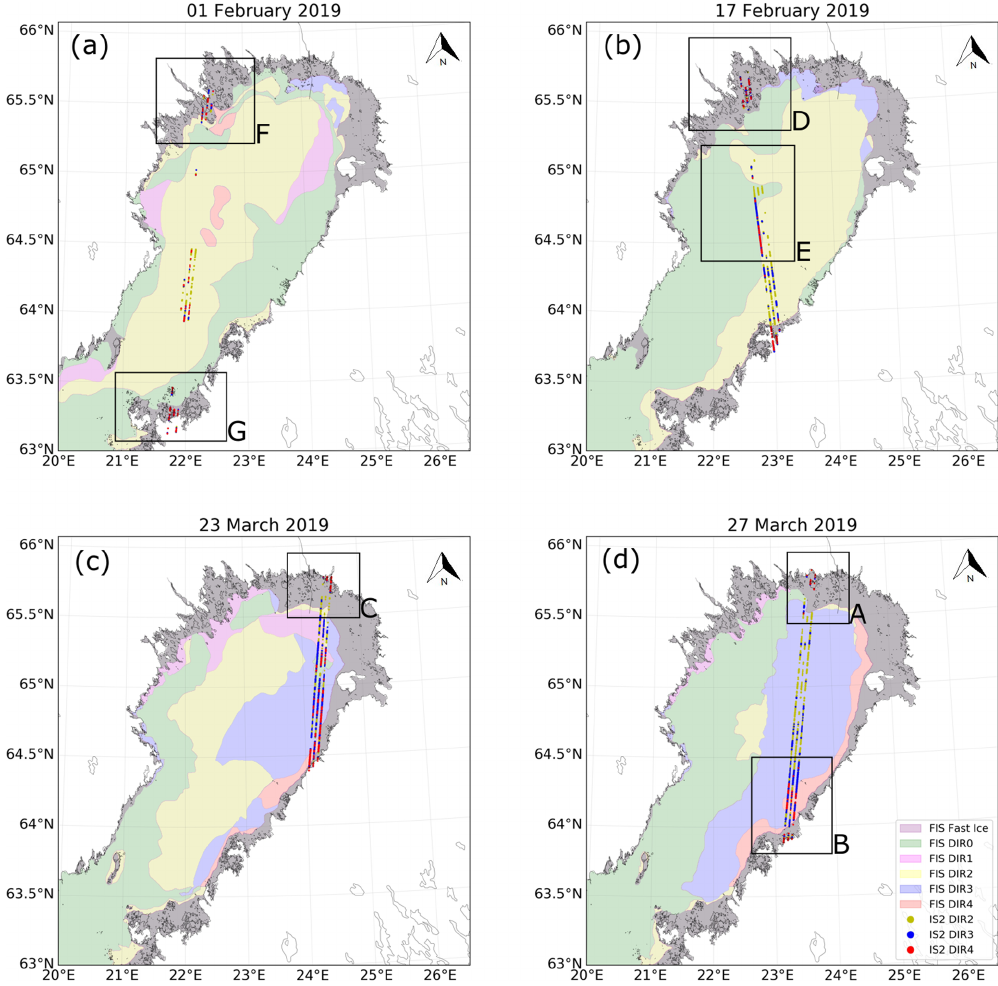
Figure 4. Categorised DIR data over four available dates (strong beams): (a) 1 February, (b) 17 February, (c) 23 March, and (d) 27 March 2019. Contours show DIR polygons derived from Finnish Ice Service (FIS) ice charts. IS2 photon heights have only been classified for DIR2–DIR4, from which several photon heights could be extracted. Darker areas close to the coast denote fast ice. A–G denote different areas of interest mentioned in the